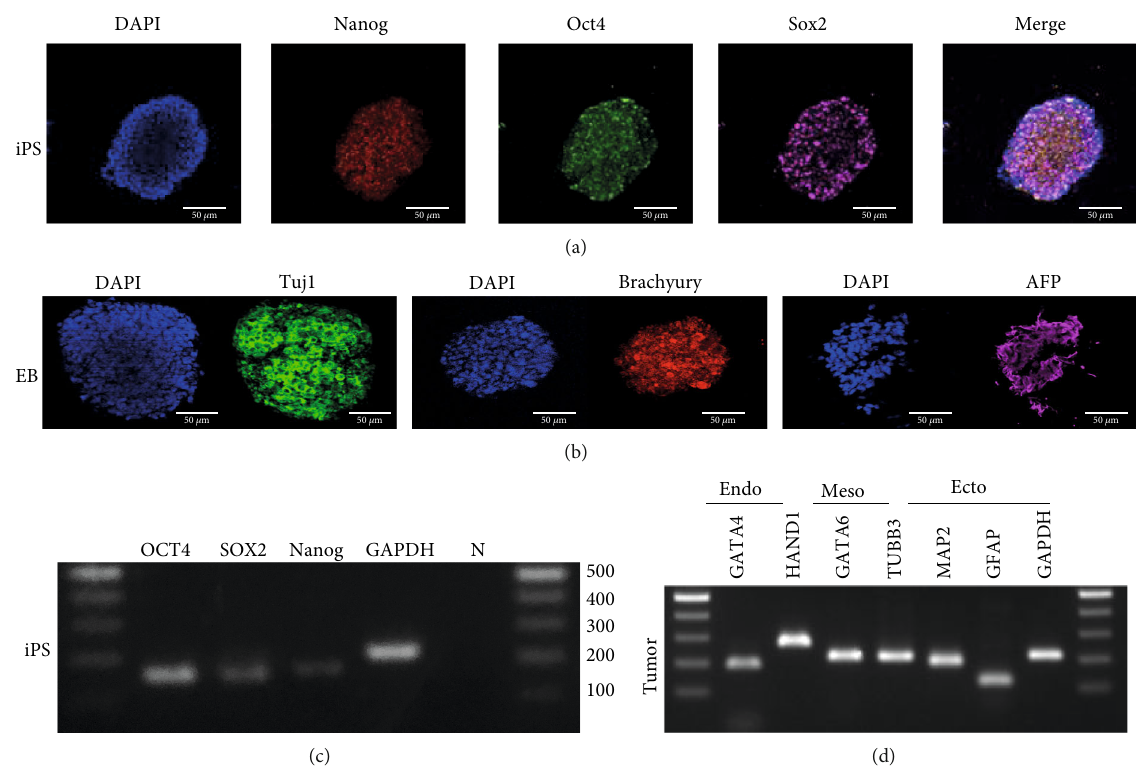
Figure 1: Characterization of iPSCs, embryoid body, and teratoma. (a) Counterstaining the nucleus with DAPI as blue color. Immuno fl uorescence staining against pluripotency markers including NANOG (red), OCT4 (green), and SOX2 (pink). The last fi gure was a merged picture. Scale bars = 50 μ m . (b) Counterstaining the nucleus with DAPI as blue color. Immuno fl uorescence staining of embryoid body di ff erentiation against TUJ-1 (ectoderm, green in color), BRACHYURY (mesoderm, red in color), and AFP (endoderm, pink in color). (c) RT-PCR of pluripotency gene expressions of iPSCs. The iPSCs were positive for pluripotency markers including OCT4 , SOX2 , and NANOG . (d) RT-PCR of gene expression of iPSC-derived teratoma. The teratoma expressed genes of three germ layers, including GATA4 (endoderm), HAND1 , GATA6 (mesoderm), TUBB3 , MAP2 , and GFAP